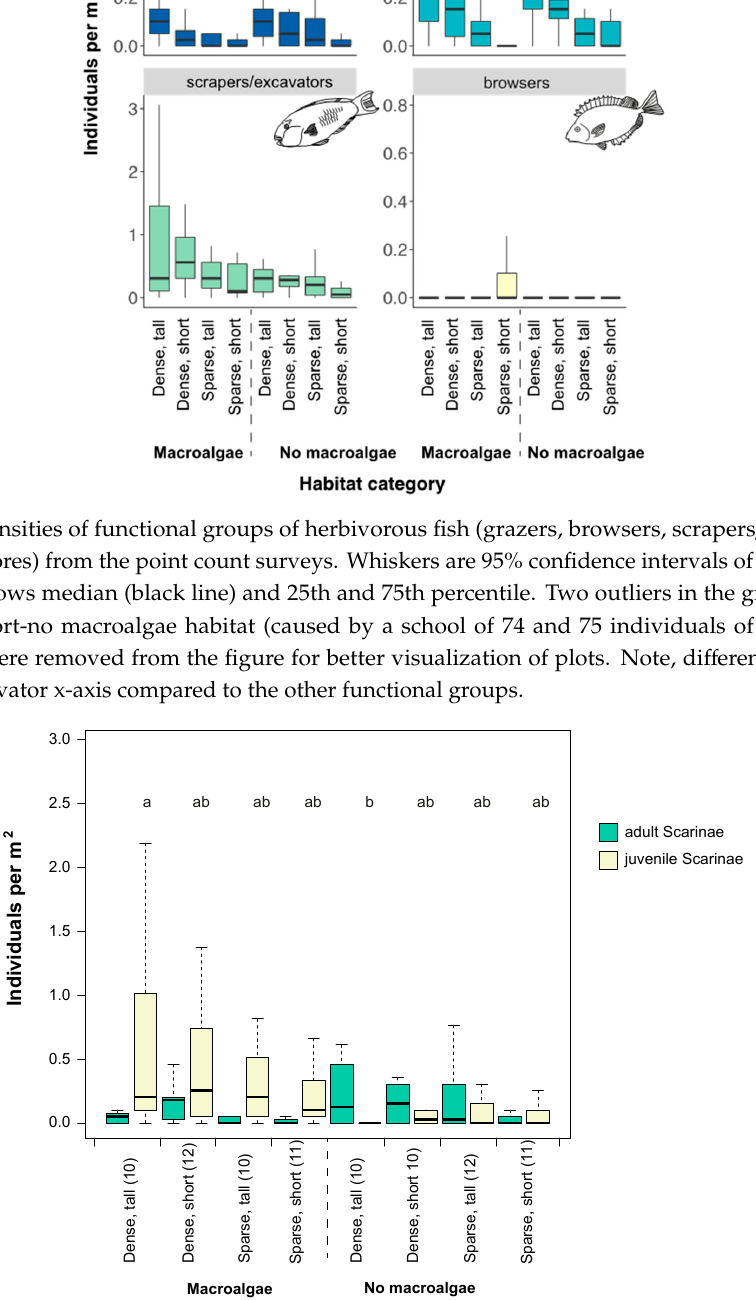
Figure 5. Densities of size classes of scraping / excavating parrotfish in di ff erent seascape configurations